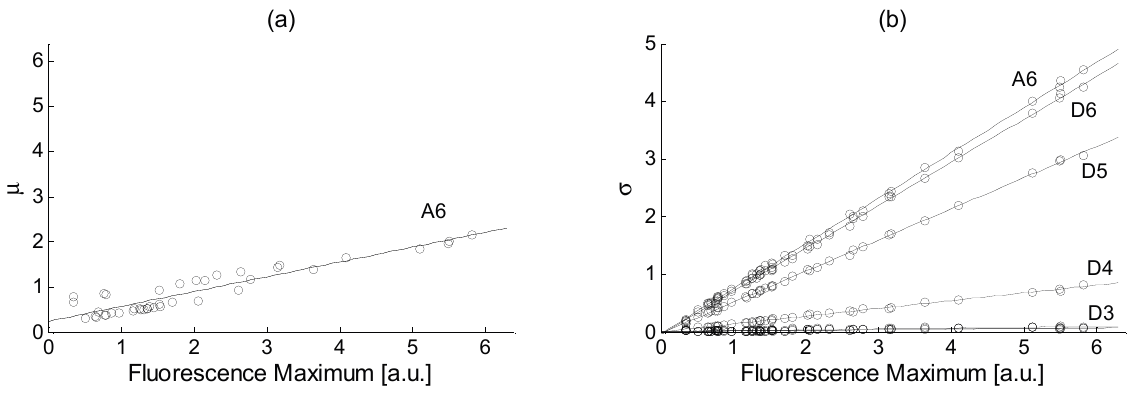
Figure 4. ( a ) Mean ( (cid:2020) ) plotted against fluorescence maximum for the approximation coefficients at level 6, and ( b ) standard deviation ( (cid:2026) ) plotted against